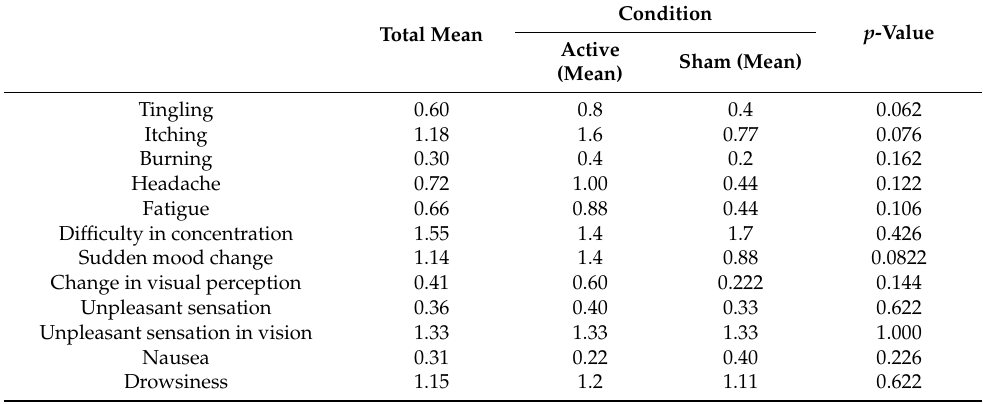
Table 6. Comparing the severity (out of 5) of side effects between active and sham groups for the PPC (posterior parietal